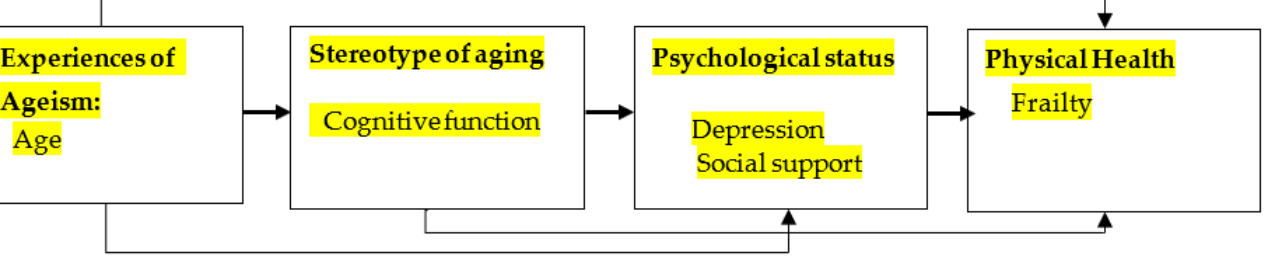
Figure 1. Conceptual framework of hypothesized model.